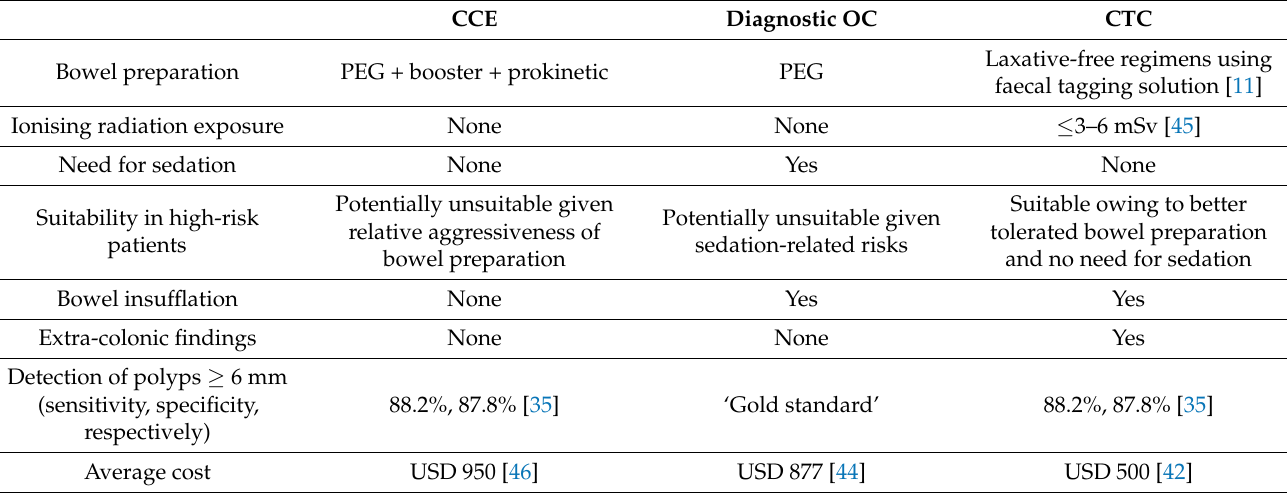
Table 5. Comparison between CCE, OC and CTC.